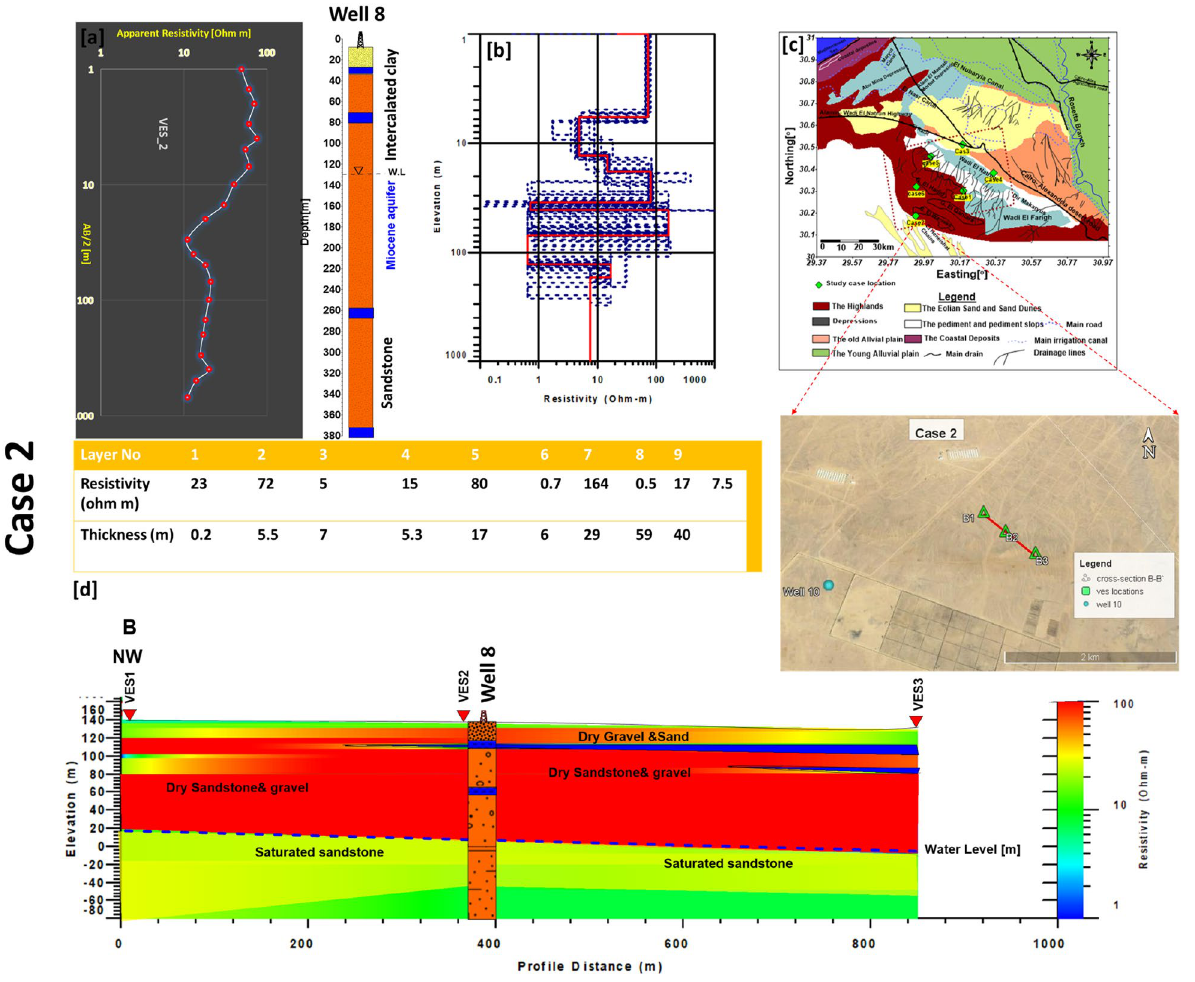
Figure 6. ( a ) VES2 as example for case 2 with Well 8, ( b ) inverted model with cumulative models, ( c ) the location of BB` cross section in the study area, ( d ) inverted resistivity cross section BB ′ in the Second study